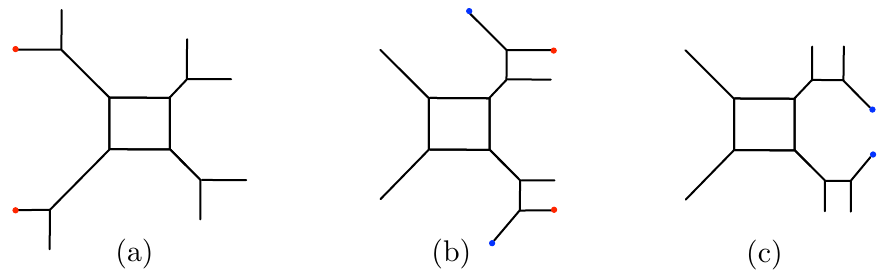
Figure 11 . 5-brane webs for SU(2)+4 F . (a) A typical 5-brane web. (b) Performing Hanany-Witten moves to the left. (c) A 5-brane configuration as a D 3 -type quiver, “SU(1)” − SU(2) − “SU(1)”, after further Hanany-Witten